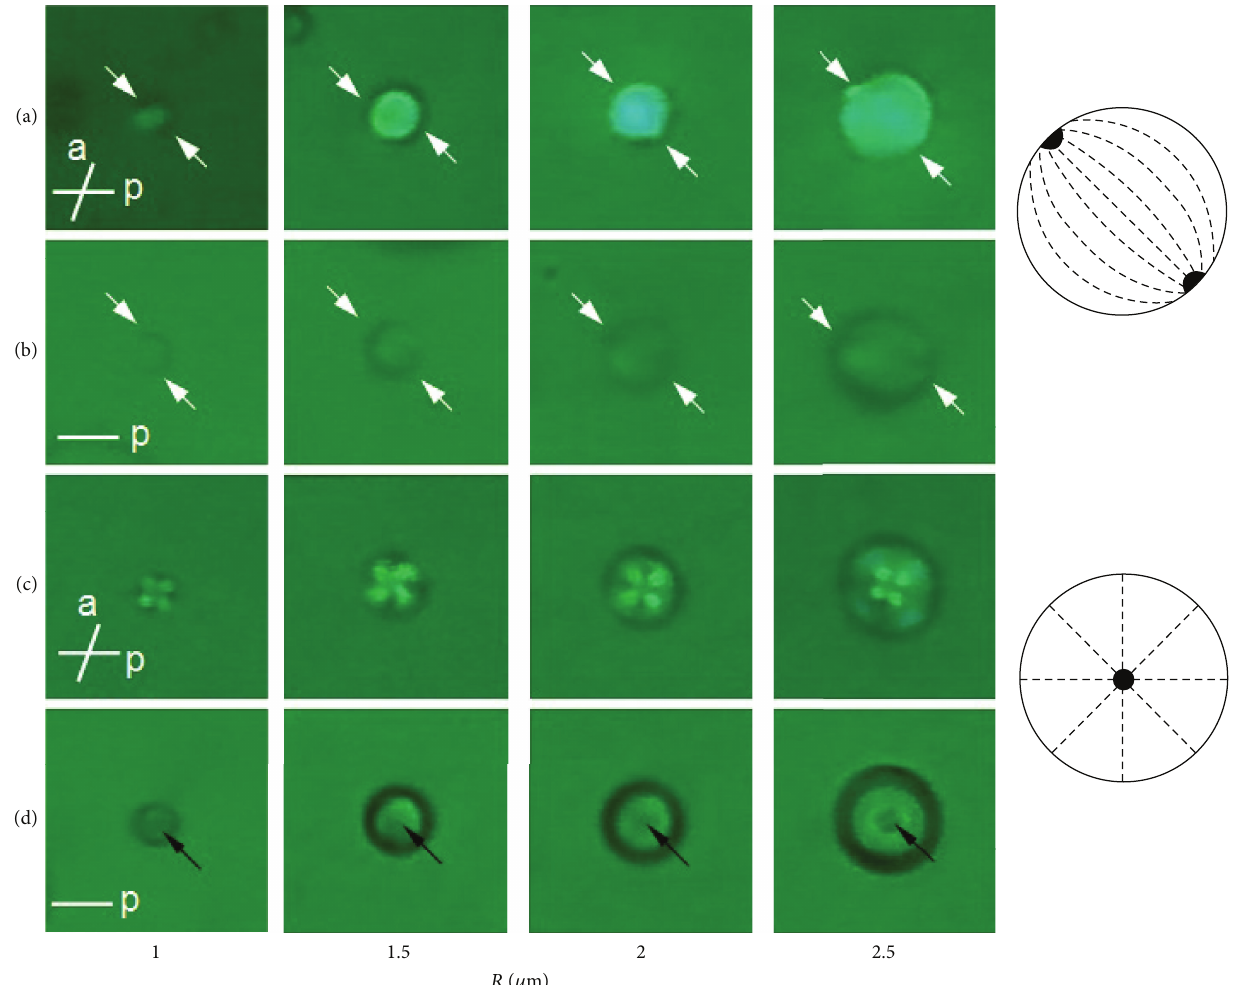
Figure 5: Interference textures of LC droplets of different radii obtained for crossed (a, c) and switched off analyser (b, d) in absence and presence of phospholipid: (a, b) 𝑐 = 0 , (c, d) 𝑐 = 10 −3 g/mL. At the right panel we schematically plot typical bipolar (top) and radial (bottom) nematic structure. With white (black) arrows we mark positions of boojums (hedgehog) in bipolar (radial) structure. In (a) and (c) the polarizers are crossed at an angle of 70 degrees.